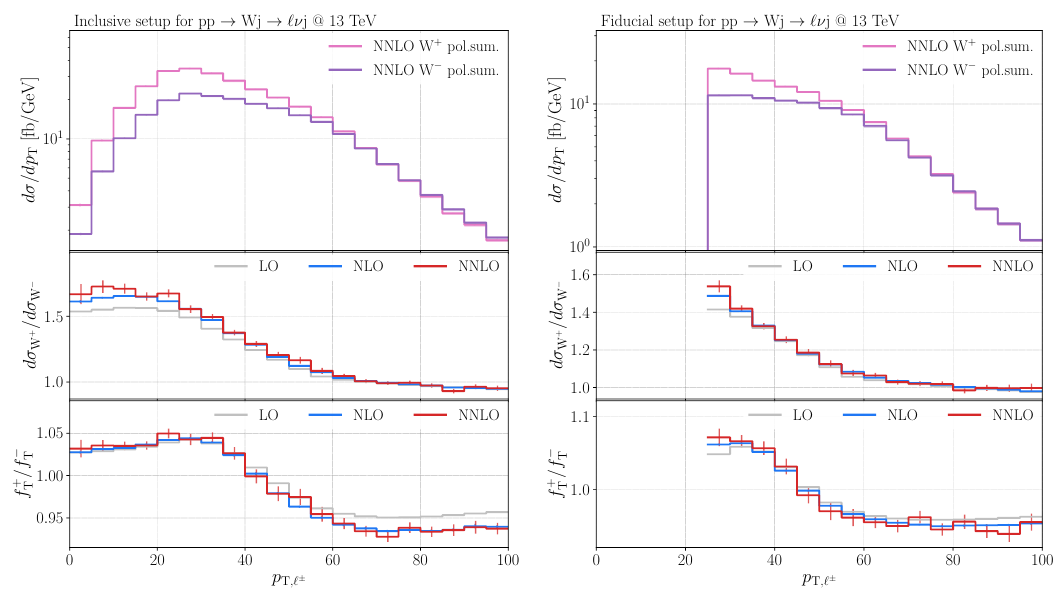
Figure 10 . Differential distributions of p T ( ‘ ) for pp → ‘ ± ( − ) ν ‘ j in the inclusive (left) and fiducial (right) setup. same individual plot structure as in figure 9.